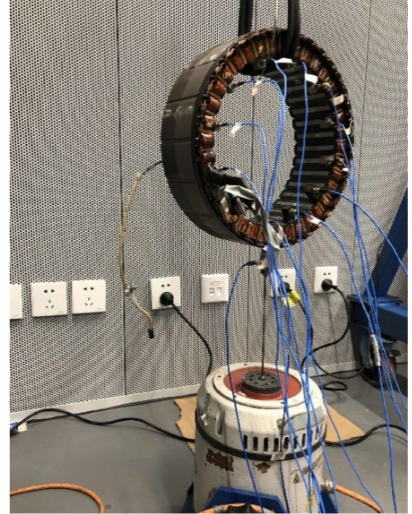
Figure 6. Installation of the modal